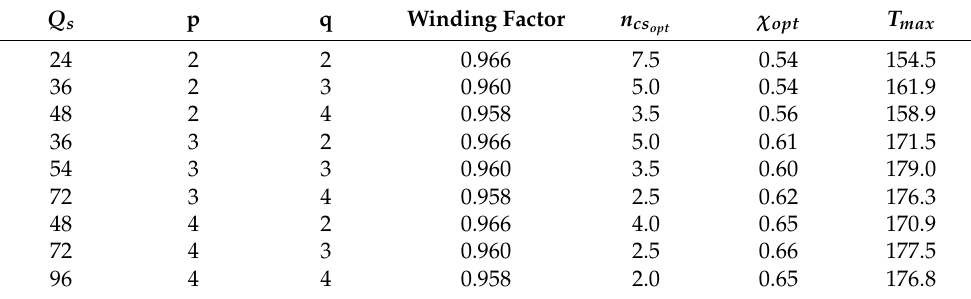
Table 2. The Selected Slot–Pole Combinations with Their Optimal Split Ratio and